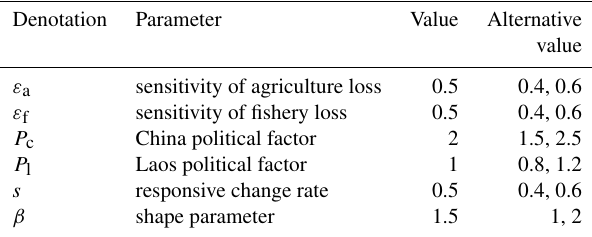
Table 3. Critical parameters and values for uncertainty